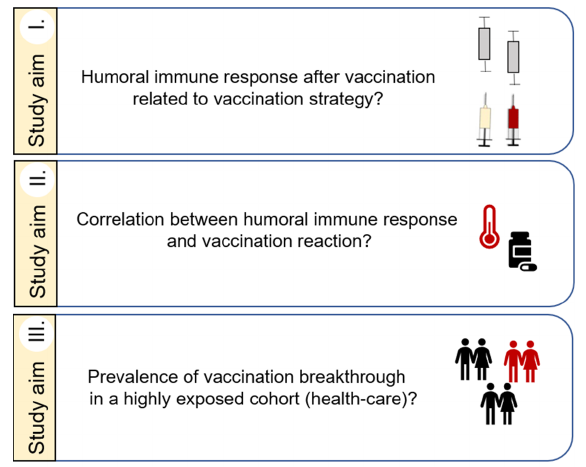
Figure 1. Study Figure 1. Study aims.